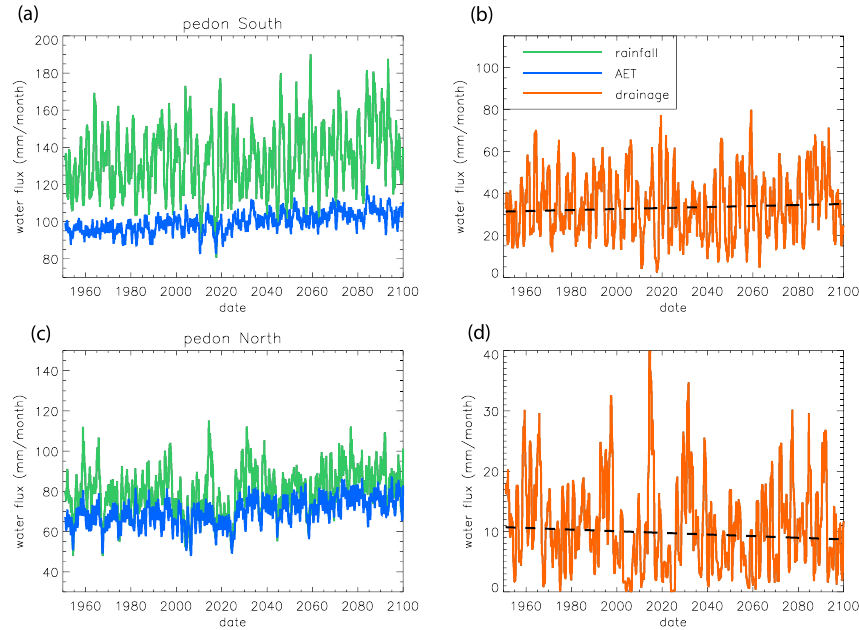
Fig. 1. The calculated water budget for the southern ( (a) and (b) ) and northern ( (c) and (d) ) sites. The increase in evapotranspiration driven by the temperature rise offsets the drainage response to the global warming. The 1-yr running means of the monthly outputs are plotted. The dotted lines are the mean square linear fits of the vertical drainage evolution at the basis of the pedons.